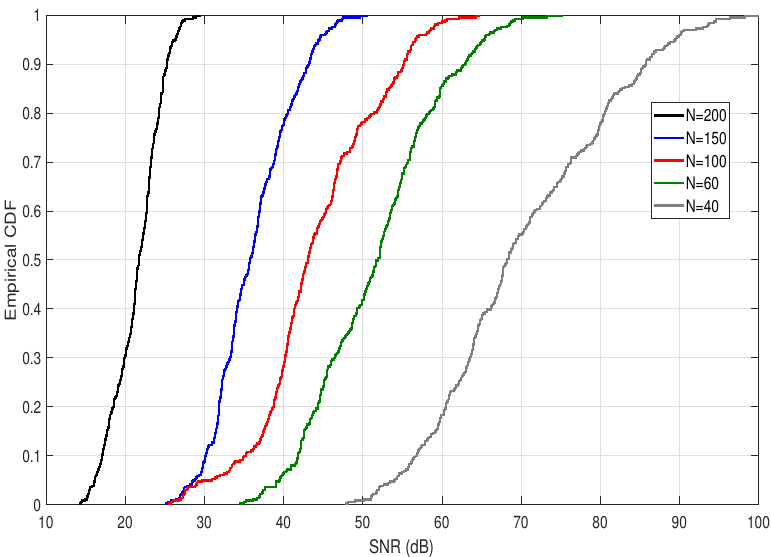
Figure 6. Empirical CDF of the SNR obtained for different values of N in the hemispheric area of the UM-VLC scenario